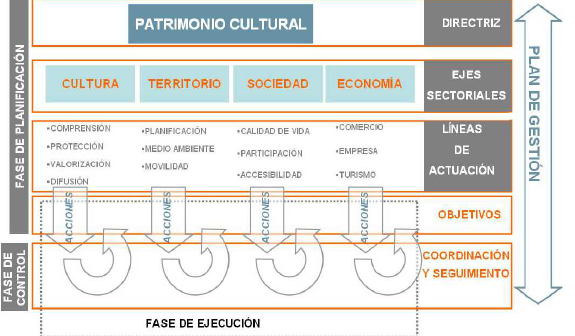
Figure 4- Table with sectors of culture connected to with lines of action, objectives and control phases and